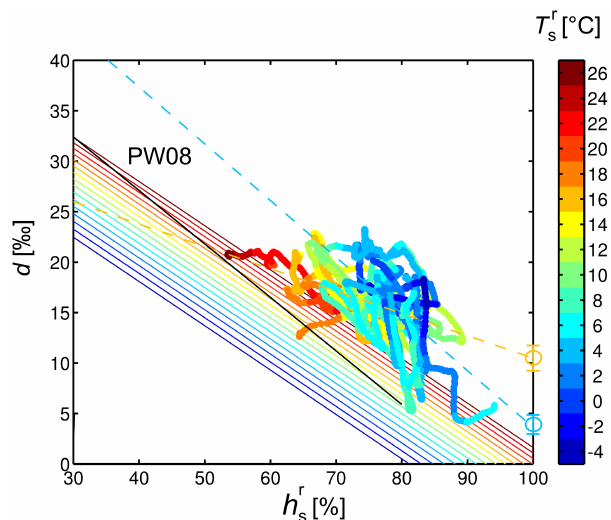
Fig. 10. The d – h r s relations for HRA events. The colour bar indi- cates diagnosed ground temperature T r s at the point of evaporation. The solid coloured and black lines are as in Fig. 1. The dashed or- ange line represents the linear regression of the d measurements against the moisture source h r s for T r s ≥ 10 ◦ C: d = − 0 . 22 · h r s + 33 and thus a source d r s of 11‰. The dashed blue line represents the linear regression of the d measurements using the moisture source h r s in winter for T r s < 10 ◦ C: d = − 0 . 56 · h r s + 60 and thus a source d r s of